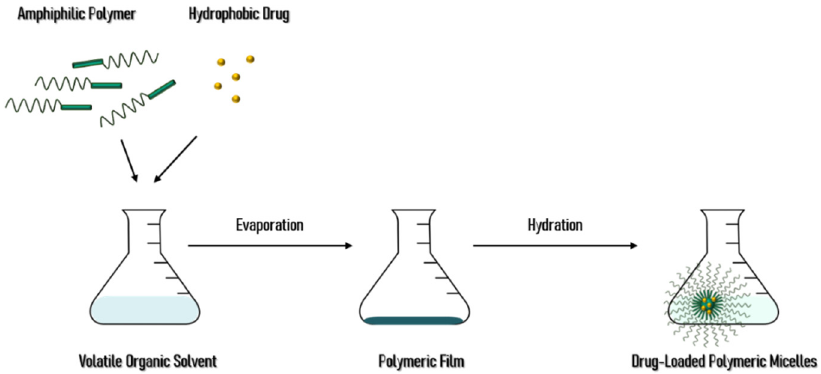
Figure 3. Schematic representation of the solvent evaporation process for polymeric micelle’s prep- aration.